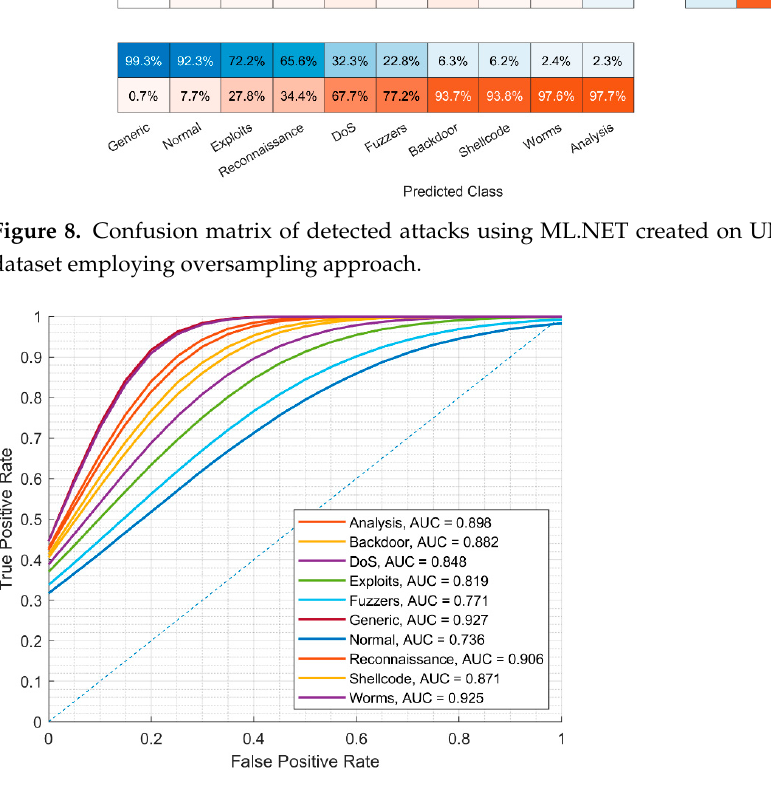
Figure 9. ROC curve of detected attacks using ML.NET created model on UNSW-NB15 training dataset employing oversampling approach.